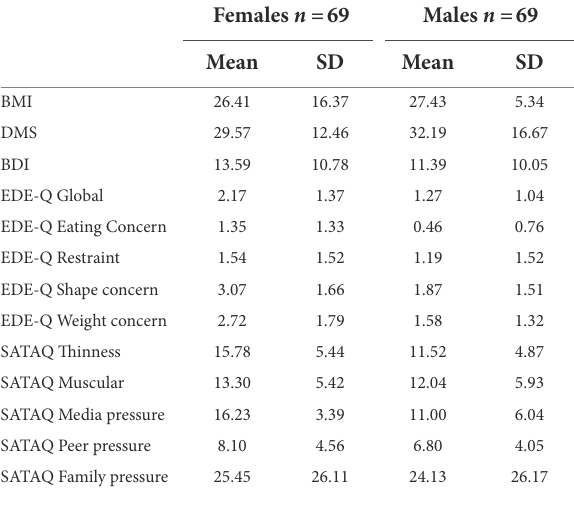
TABLE 1 Participant characteristics and psychometric scores for Study